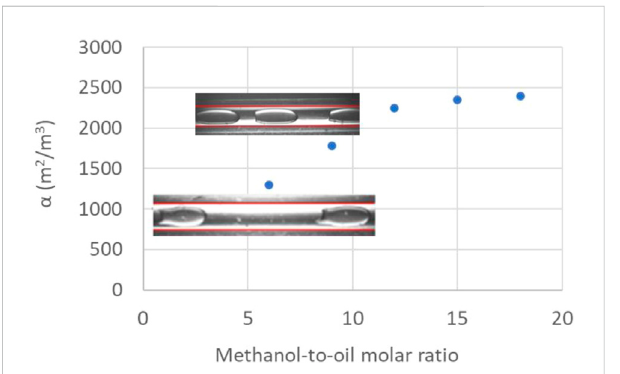
FIGURE 6 Biodiesel yield as a function of methanol-to-oil molar ratio and catalyst concentration (constant temperature 60 ° C, constant residence time 70